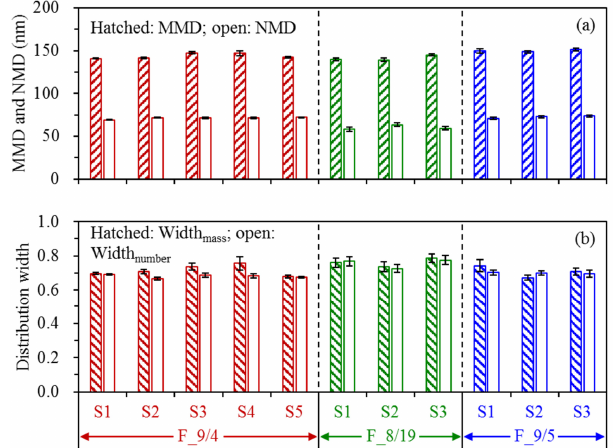
Figure 10. In-plume rBC MMD and NMD (a) , and mass and num- ber distribution widths (Width mass and Width number ; b ) derived from successive flight screens of the three transformation flights. The results are also available in Table